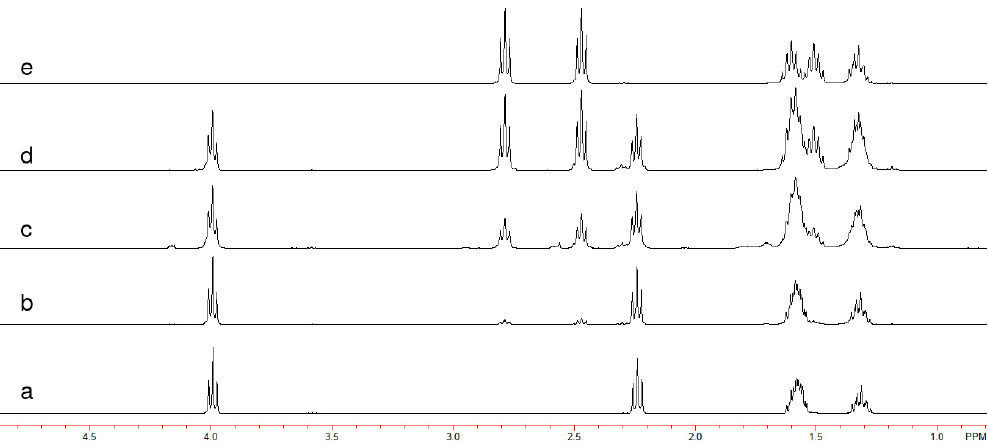
Figure 2. 1 H-NMR spectra of ( a ) PCL, ( e ) PTCL, and COP copolymers with molar proportions of ( b ) 2:1, ( c ) 1:1, and ( d ) 1:2.